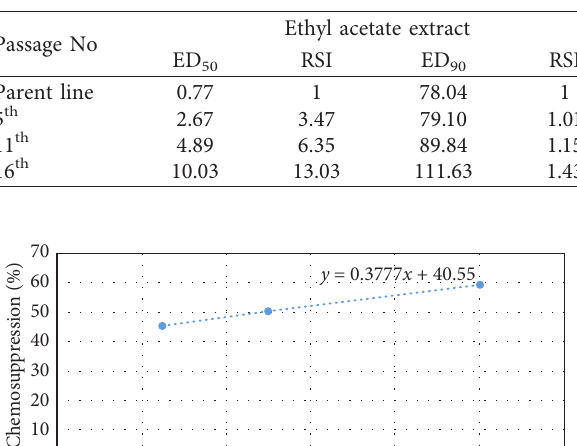
Table 7: Summary of the ED50, ED90 (mg/ml.day), and resistance index values of ethyl acetate extract measured in the 4-day test during the drug selection pressure assay.